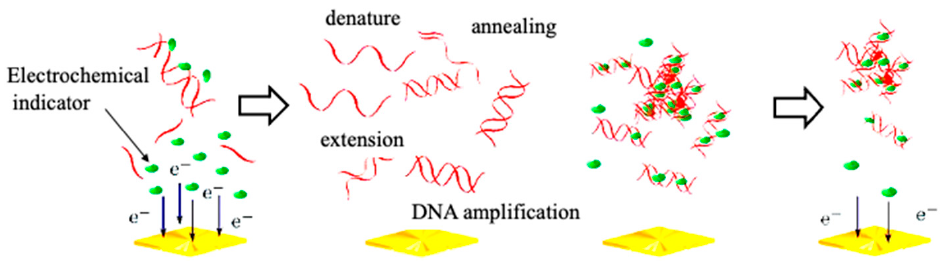
Figure 4. Scheme of electrochemical change linked with PCR amplification.